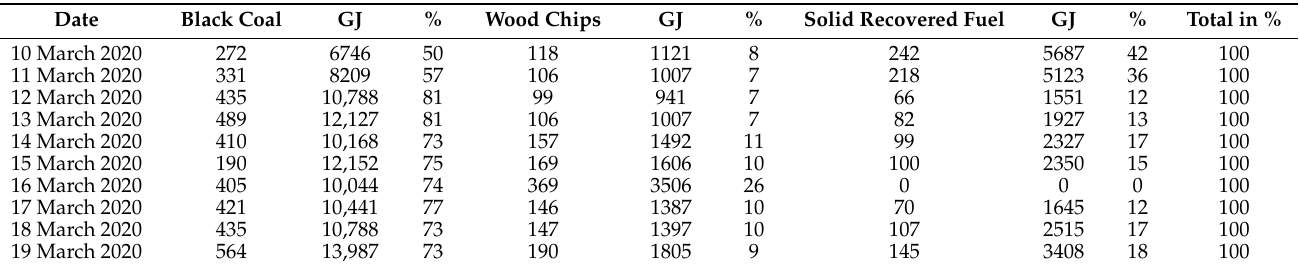
Table 7. Final combustion tests of black coal, solid recovered fuel and wood